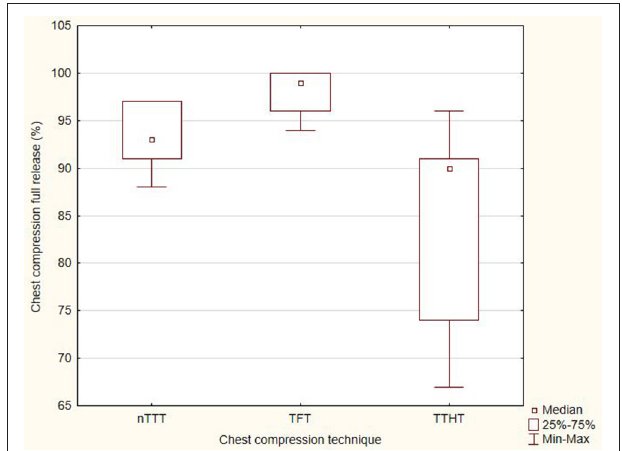
FIGURE 4 | The percentage of chest compression full release.